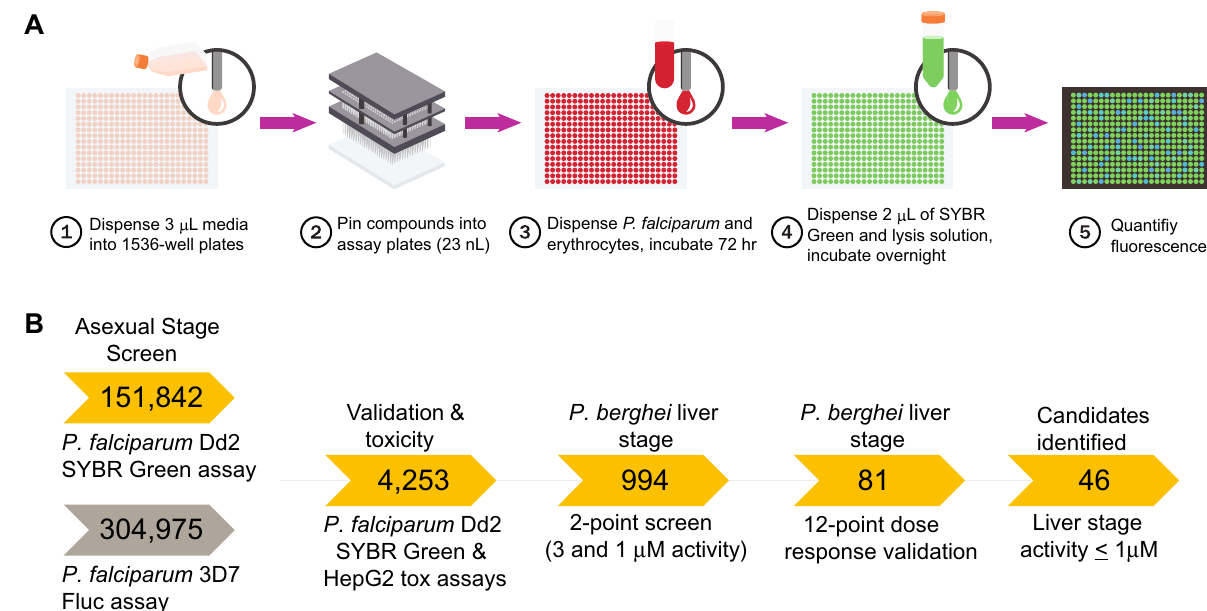
Figure 1. Implementation of a quantitative high-throughput (qHTS) screen against P. falciparum asexual blood stage parasites. ( A ) Overview of qHTS primary and secondary screens of compound libraries assayed against P. falciparum ABS parasites cultured in human RBCs. In our second major screen, growth inhibition was monitored via quantification of SYBR Green fluorescence, which detects parasite DNA in human DNA- deficient RBCs. Alternatively, inhibition of parasite proliferation was quantified by measuring luciferase activity (not shown). ( B ) Screening pipeline for identifying candidate causal chemoprophylactic antimalarials. Two large qHTS campaigns used either SYBR Green or luciferase to test for inhibition of parasite growth, assaying a combined total of 456,817 compounds. Following qHTS, manual triage selected 4253 synthetically tractable compounds for validation of antiplasmodial activity and mammalian toxicity. Compounds were then evaluated in vitro against P. berghei liver stage parasites at 3 μM and 1 μM concentrations. Selected compounds were further evaluated in a 12-point dose–response against P. berghei liver stage parasites, yielding 46 with submicromolar AC 50